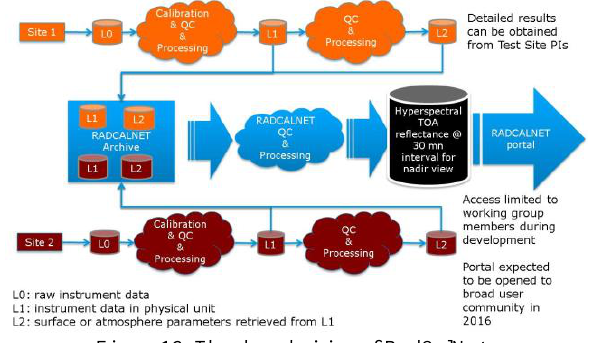
Figure 12. The shared vision of RadCalNet